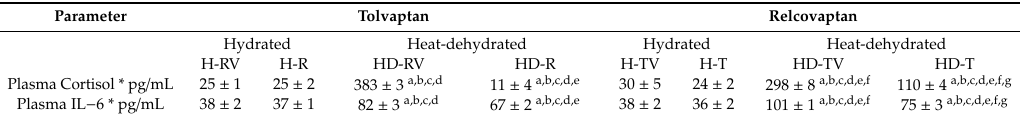
Table 2. Relcovaptan and tolvaptan partially prevented systemic inflammation and increased cortisol plasma levels induced by heat stress and rehydration with a fructose-containing beverage. Parameter Tolvaptan Relcovaptan Hydrated Heat-dehydrated